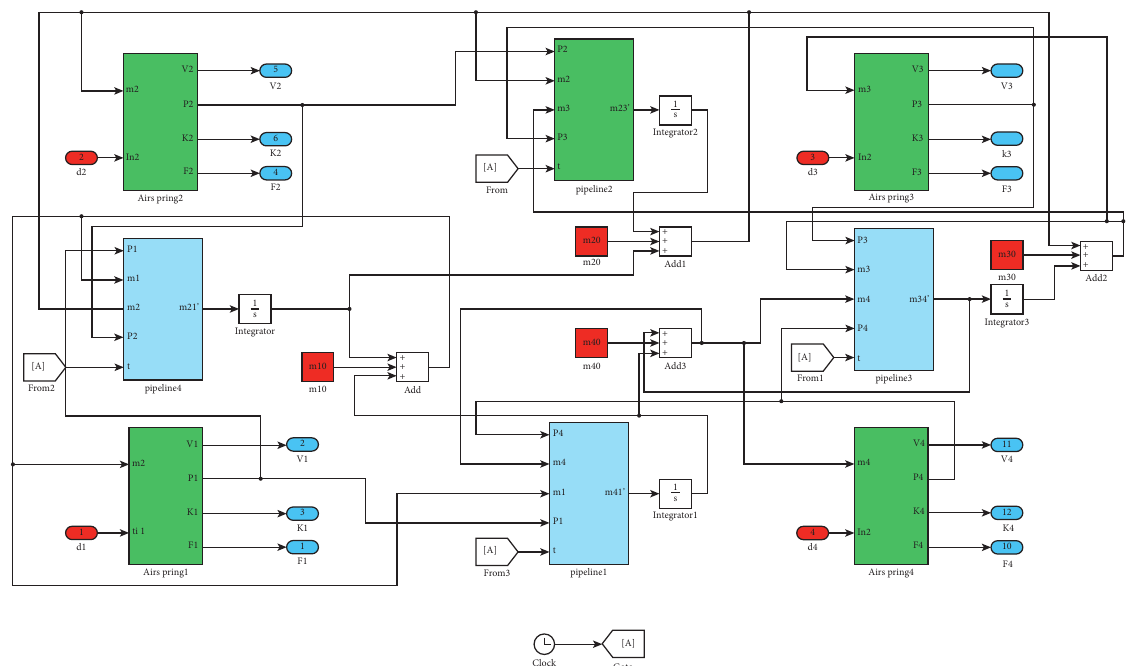
Figure 6: Simulink module of interconnected air suspension.